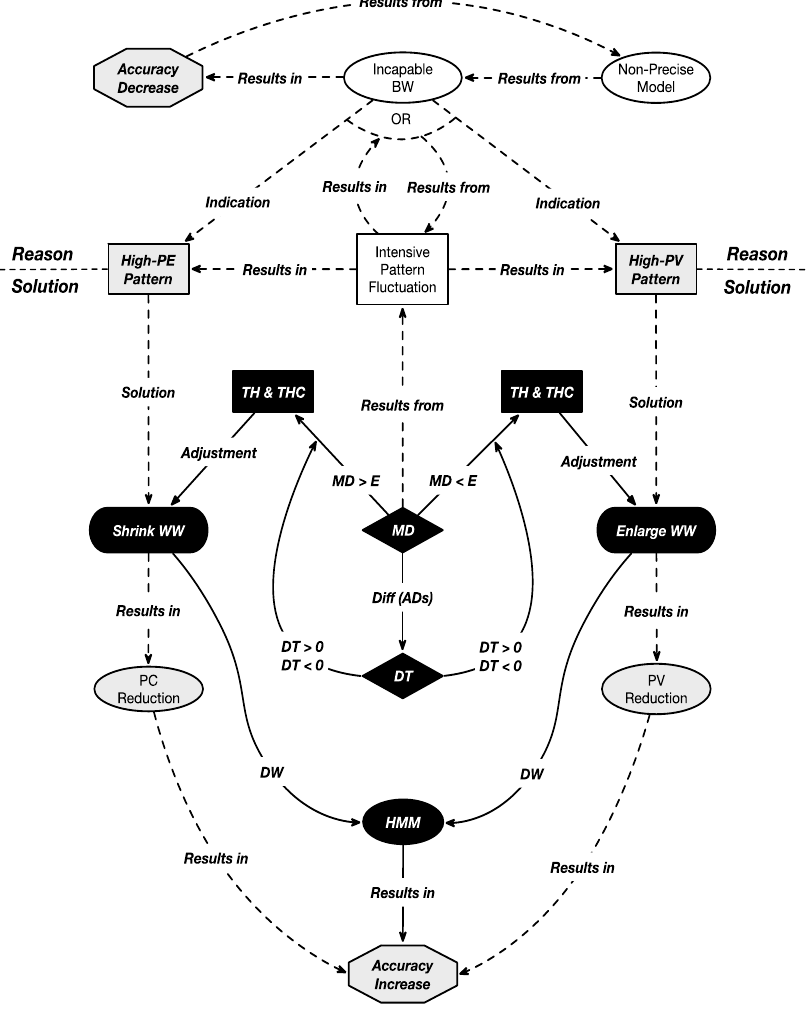
Figure 4. The logic chain of AA-HMM. * Shapes with black background are components of AA-HMM, Solid lines represent the interactions between components and dashed lines are relationship between concepts.